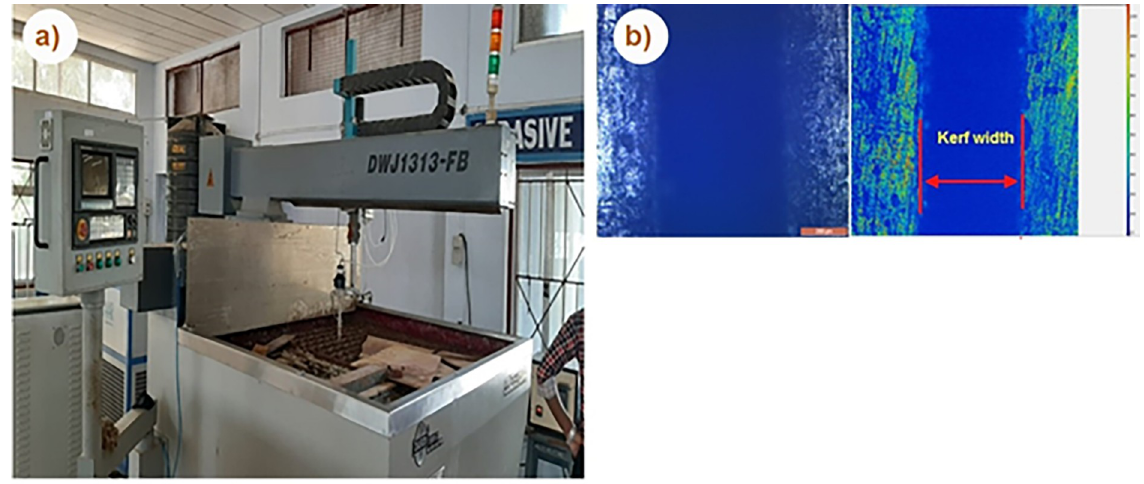
Fig 2. a) Abrasive water jet machine b) optical image of machine surface for kerf width